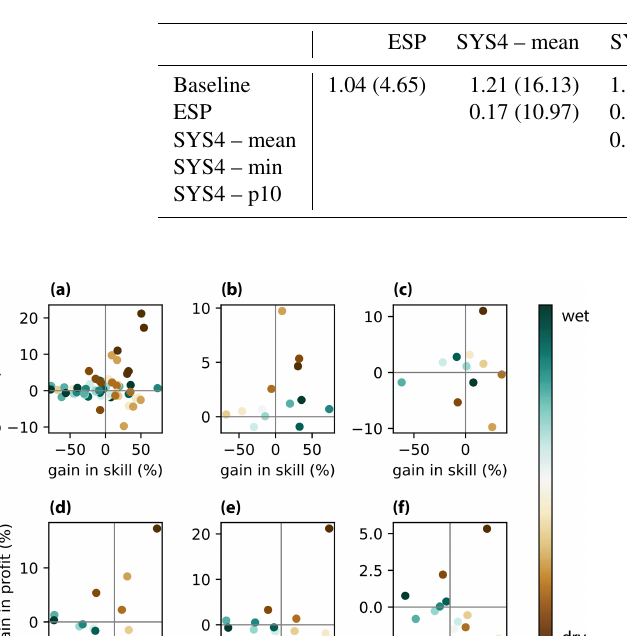
Table 3. Results of benchmarking analysis to isolate the sources of forecast value. The matrix reports the percentage change in farmers’ profit for the forecast systems in the columns with respect to the benchmarks in the rows, estimated as average over the 1996–2008 period and for the 2005 drought (in parenthesis).